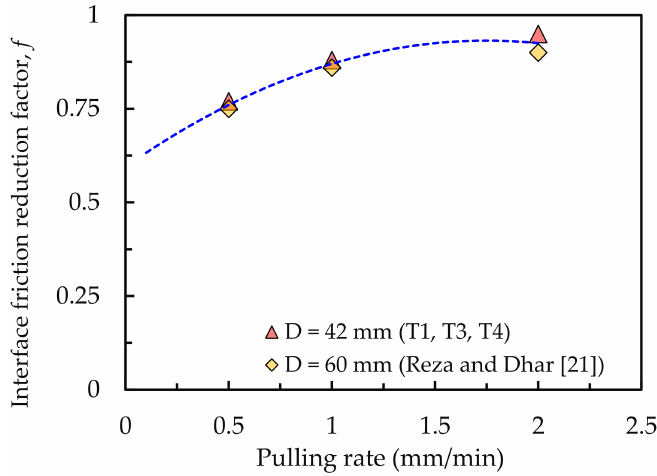
Figure 7. Interface friction reduction factor with pulling